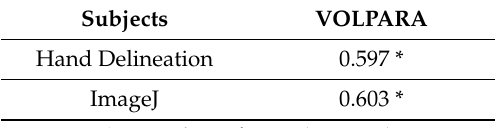
Table 4. The level of agreement using ( κ w) between Hand Delineation and ImageJ, with VOLPARA. Subjects VOLPARA Hand Delineation 0.597 * ImageJ 0.603